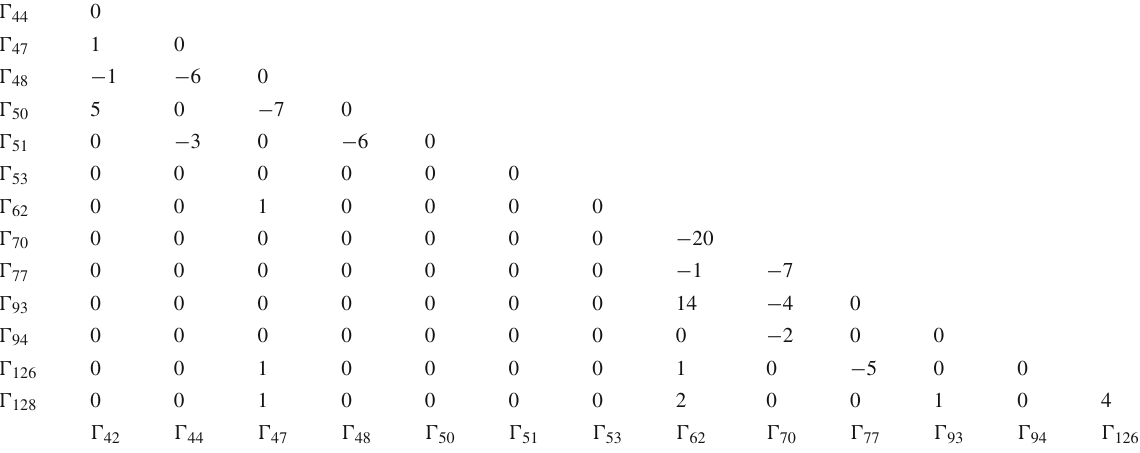
Table 309 Basis quantities correlation coefficients in percent, subtable 5